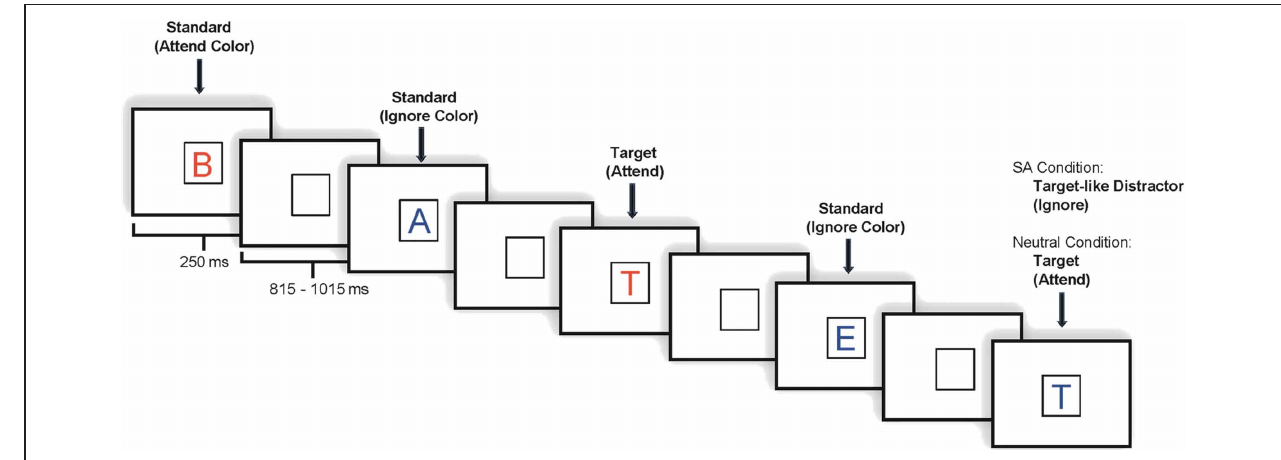
FIGURE 1 | Illustration of an experimental